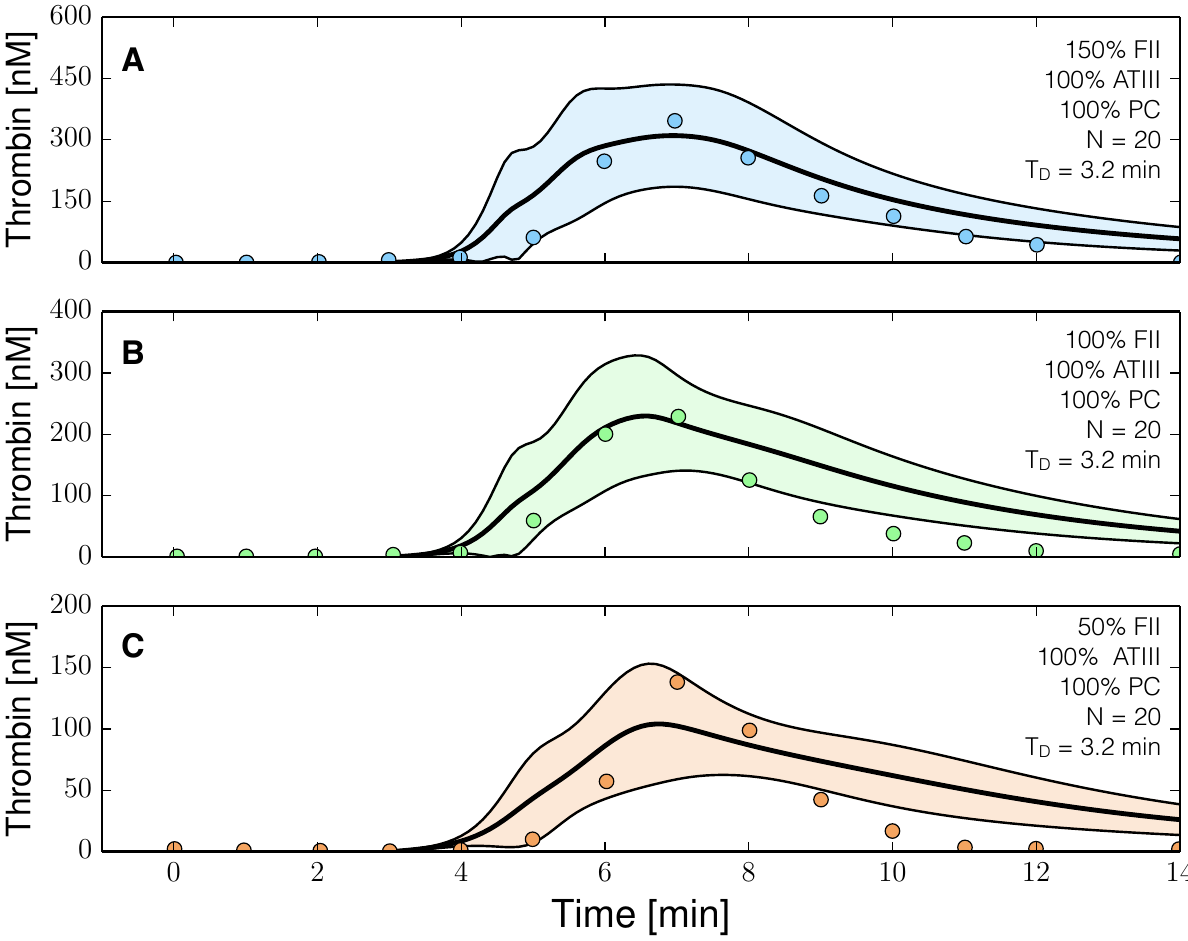
Figure 4. Reduced order coagulation model training simulations. Reduced order coagulation model parameters were estimated using particle swarm optimization (PSO) with the protein C pathway as a function of prothrombin. Only APC pathway parameters